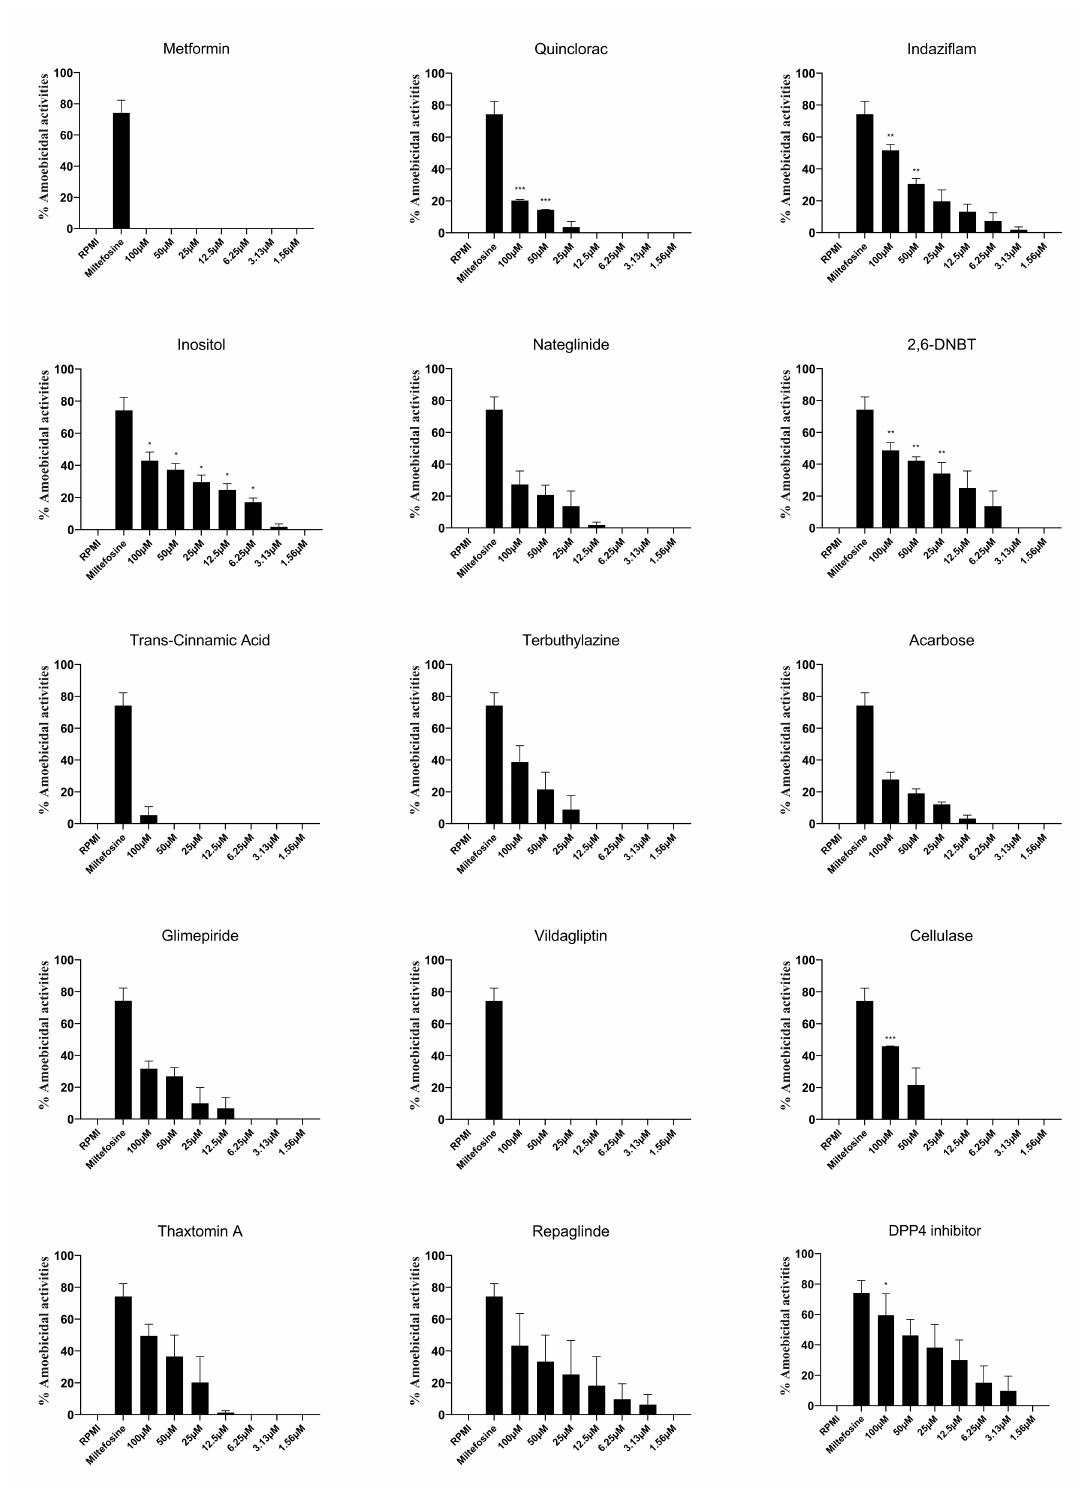
Figure 2. The amoebicidal activities of compounds against B. mandrillaris trophozoites. B. mandrillaris trophozoites were incubated with various concentrations of compounds for 24 h and trophozoites viability was determined using Trypan blue. Percentage amoebicidal activity was calculated by: [((RPMI cell count − cell count for sample)/RPMI cell count) × 100)]. The activities of solvents alone were negated from the activities of the compounds. The data is presented as the mean ± standard error (*: p < 0.05, **: p < 0.01, ***: p < 0.001 using student t -test; two tailed